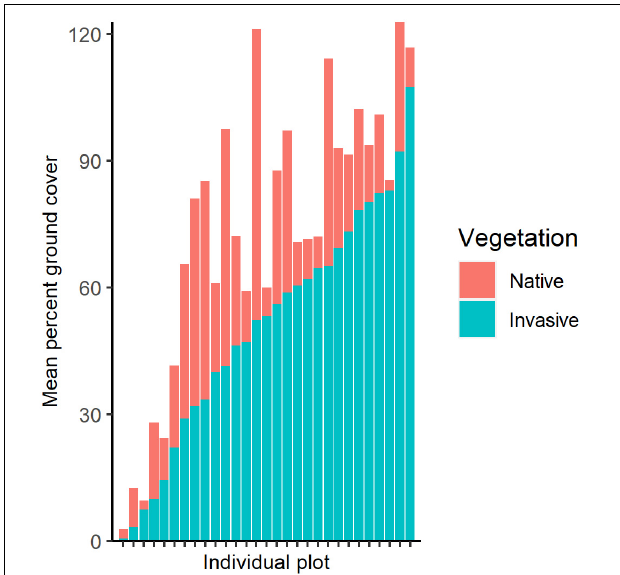
FIGURE 2 | Stacked bar chart showing mean percent ground cover of invasive and native vegetation within sampled quadrats, with each bar representing one plot. Percent ground cover can reach over 100% as cover is estimated at various heights to account for invasive shrubs and low-growing